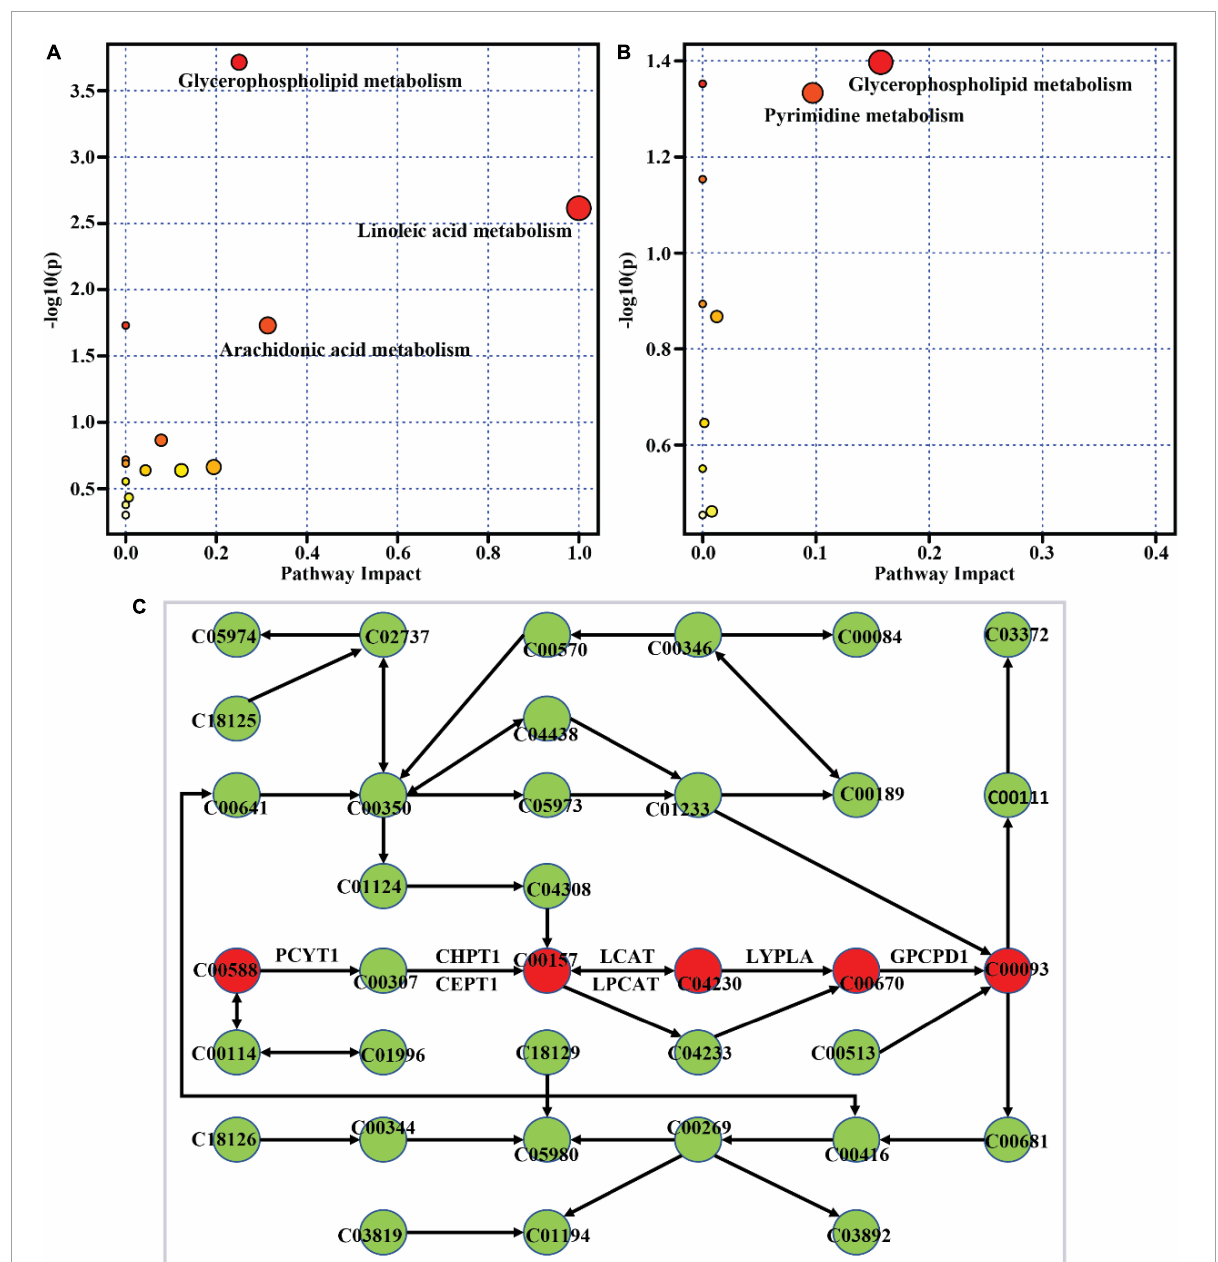
FIGURE5 Metabolic pathway enrichment of differential metabolites. (A) Mod vs. Con, (B) HD vs. Mod, (C) the enriched glycerophospholipid metabolism pathway generated by MetaboAnalyst. The red circle indicates the enriched differential metabolite. C00588, Choline phosphate; C00307, CDP-choline; C00157, Phosphatidylcholine; C04230, 1-Acyl-sn-glycero-3-phosphocholine; C00670, Glycerophosphocholine; C00093, Glycerophosphoric acid; PCYT1, choline phosphate cytidylyltransferase; CHPT1, diacylglycerol choline phosphotransferase; CEPT1, choline/ethanolamine phosphotransferase; LCAT, lecithin-cholesterol acyltransferase; LPCAT, lysophosphatidylcholine acyltransferase/lyso-PAF acetyltransferase; LYPLA1, lysophospholipase I; GPCPD1, glycerophosphocholine phosphodiesterase.